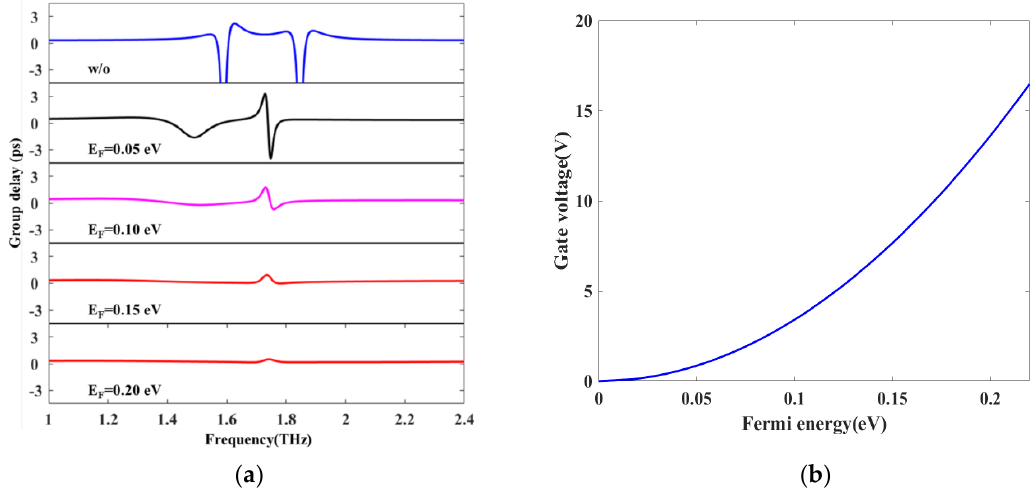
Figure 6. ( a ) The group delay of the hybrid metamaterial with and without the graphene layer; ( b ) the approximate relation between the gate voltages and the Fermi energy.